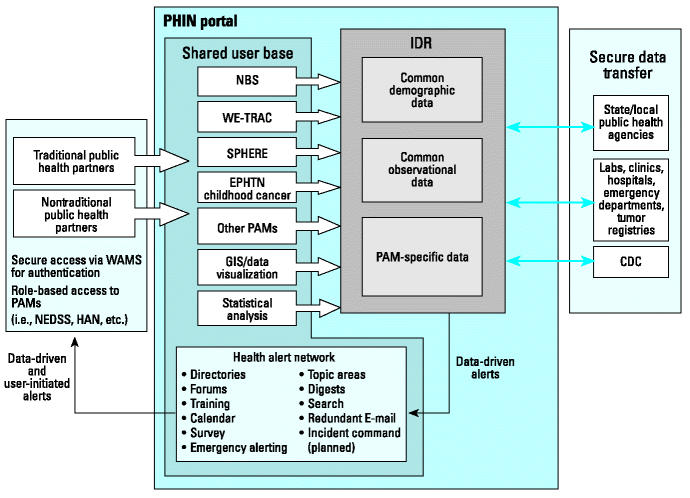
WI-PHIN information flows and services. Abbreviations: HAN, Health Alert Network; PAMs, program area modules; WAMS, State of Wisconsin Web Access Management System.